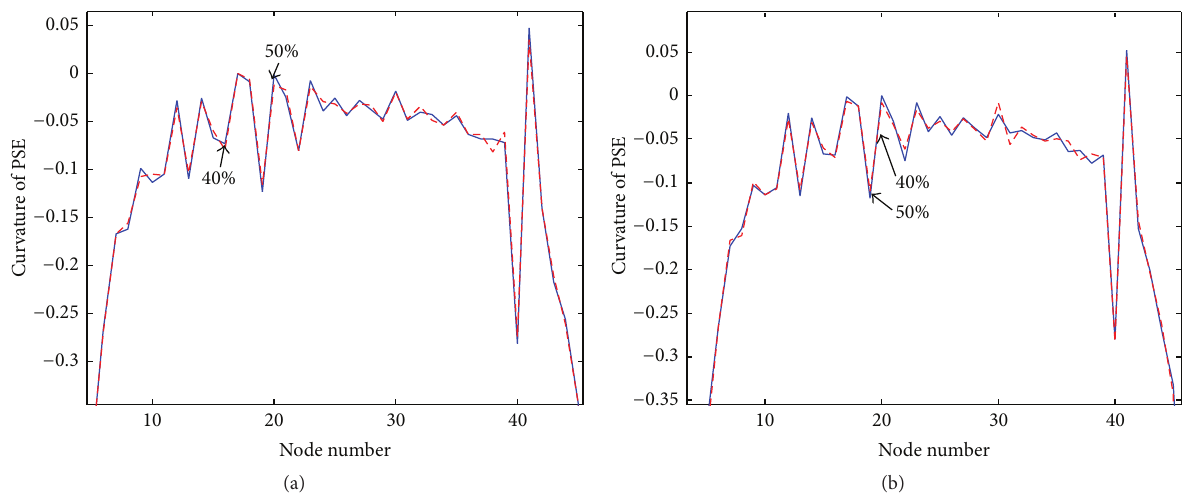
Figure 6: PSE curvature depending on the overlap: (a) rectangular window, (b) Hamming window.